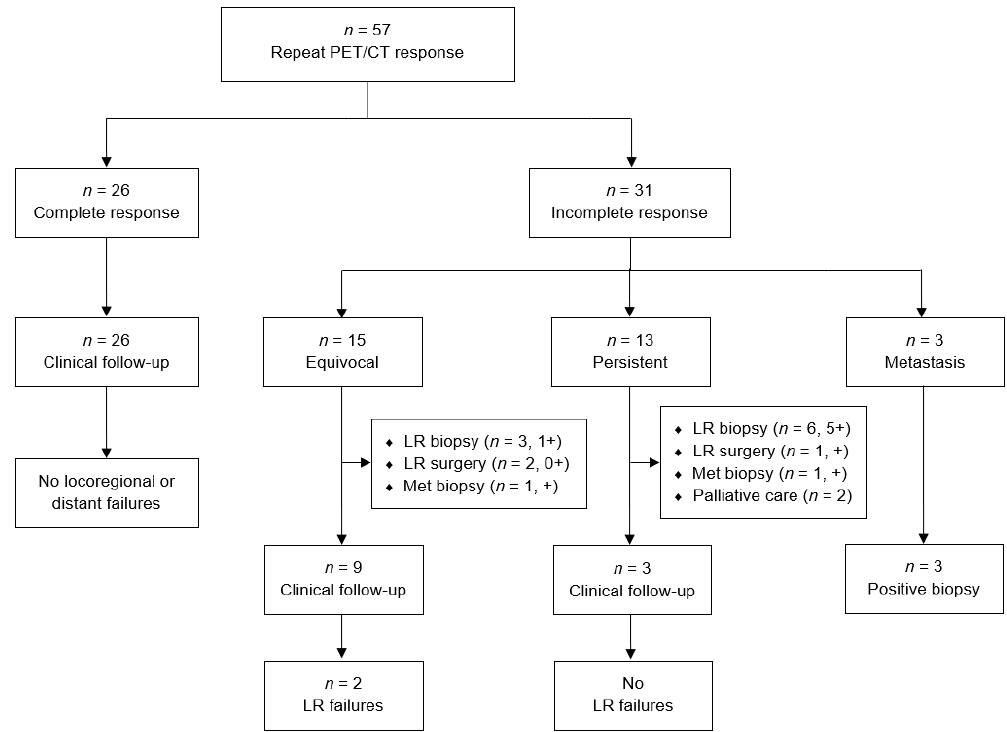
Figure 4. Flowchart of patient responses and clinical outcomes following repeat PET/CT scan.